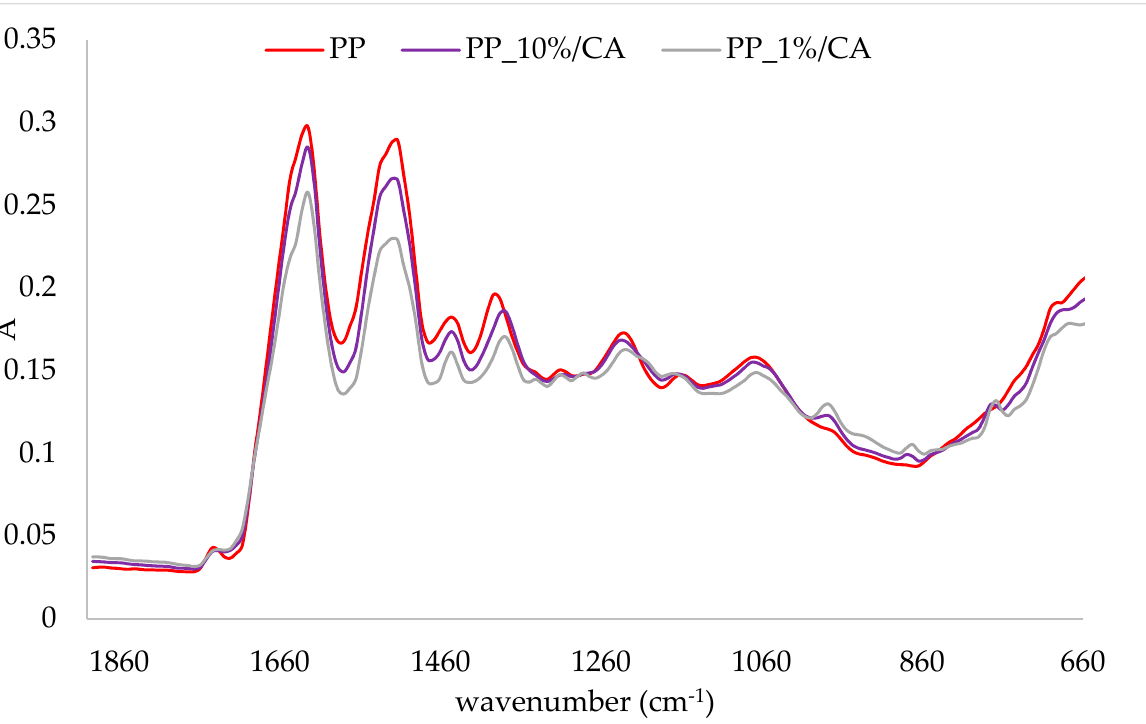
Figure 1. IR spectra of pea protein (PP) and obtained complexes with cinnamic acid (PP_10%CA—complex prepared with 10% of protein matrix; PP_1%CA—complex prepared with 1% of protein matrix).